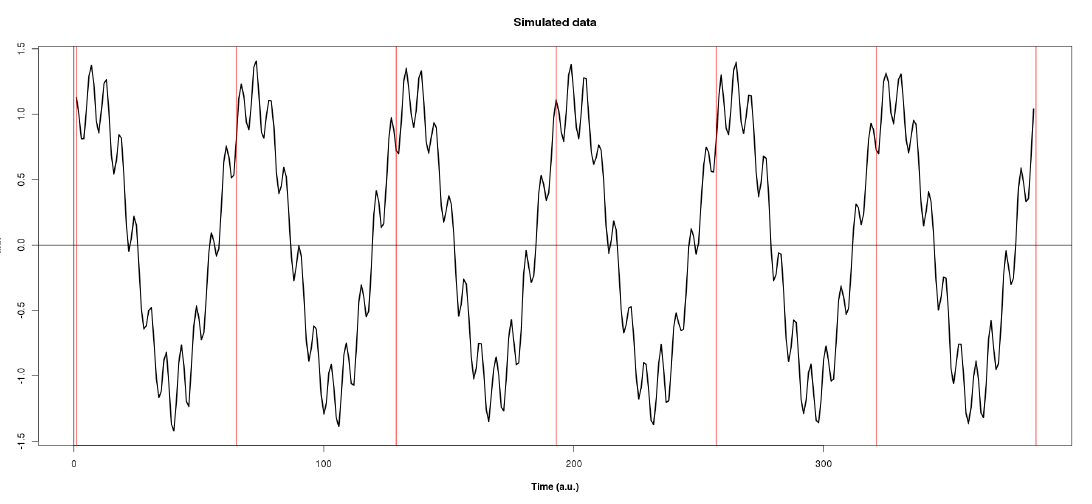
Figure 3. Simulated signal generated via model